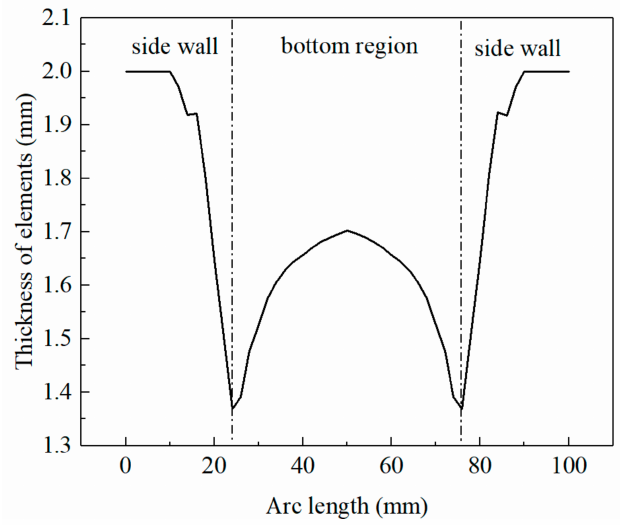
Figure 15. The thickness distribution of the component predicted by